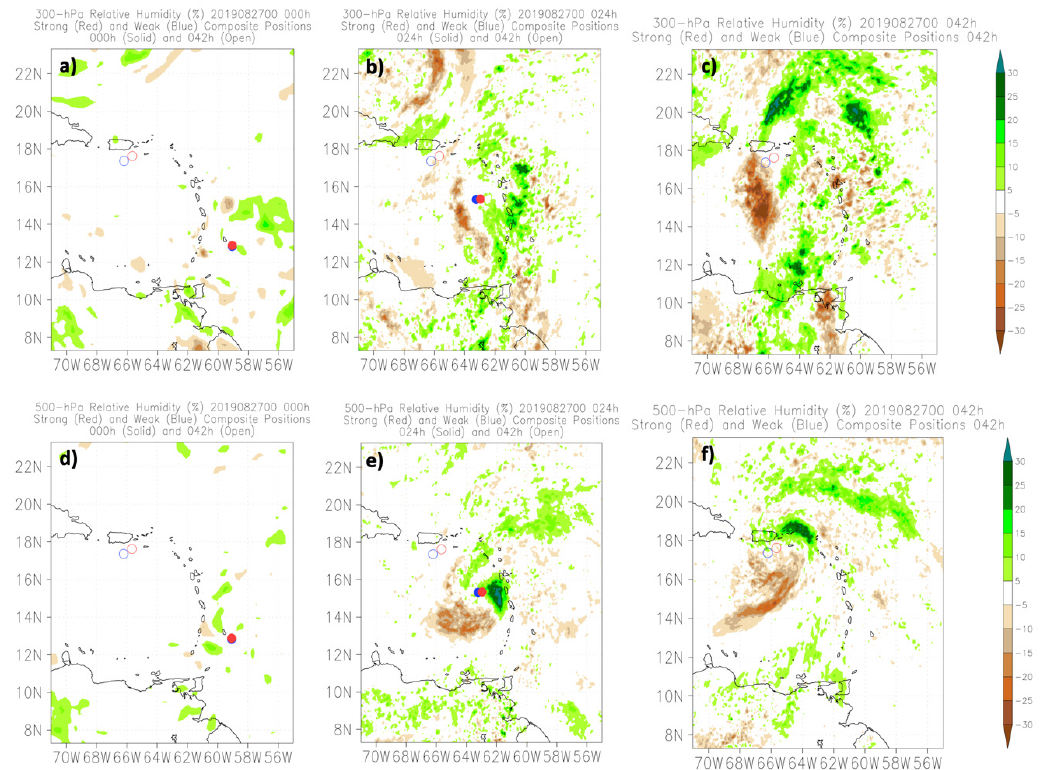
Figure 7. ( a ) 300-hPa relative humidity (%) difference between the composite of the 20 strongest members and 20 weakest members (based on minimum pressure at 42 h) at 0 h (initialization). The solid circles show the mean position of the strong group (red) and weak group (blue) at 0 h, and the open circles show the positions at 42 h. ( b ) As in ( a ), but at 24 h. ( c ) As in ( a ), but at 42 h. ( d ) As in ( a ), but for 500-hPa relative humidity. ( e ) As in ( d ), but at 24 h. ( f ) As in ( d ), but at 42 h.